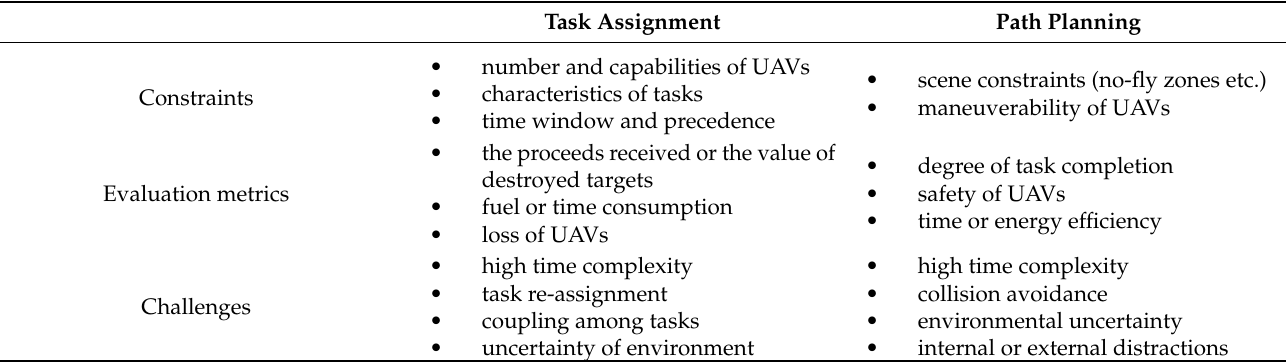
Table 1. Issues to be considered in practical